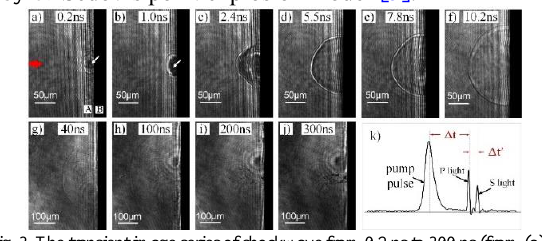
Fig. 3. The transient image series of shockwave from 0.2 ns to 300 ns (from (a) to (j)) and the schematic diagram of S-P light method (k). Pump laser comes along with red arrow and the white arrow means the plasma region.